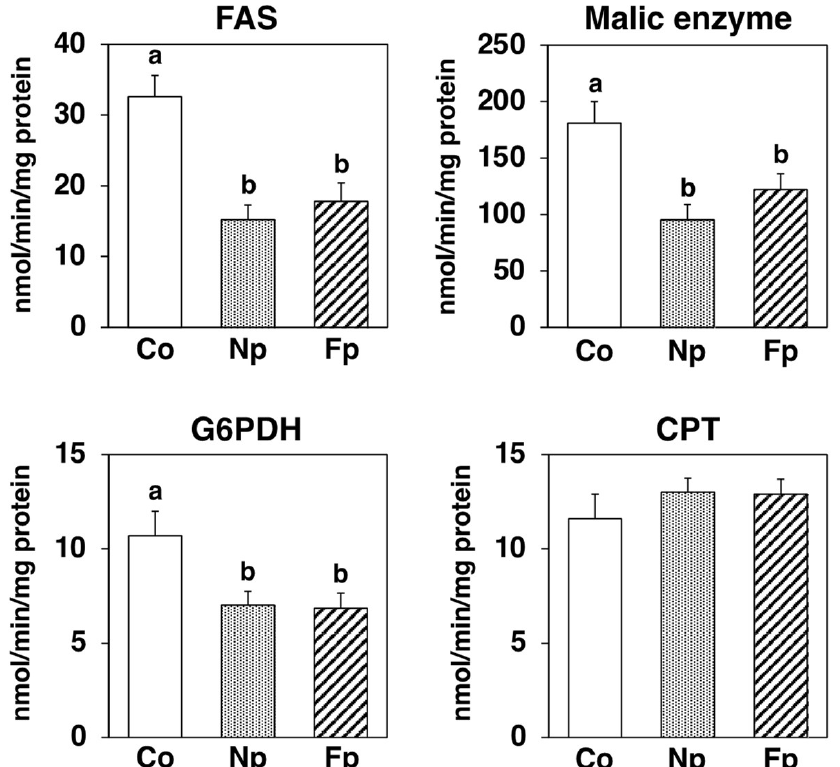
Figure 5. Activities of hepatic enzymes related to lipid metabolism in db / db mice fed a basal diet (Co group), 10% NP-supplemented diet (Np group), or 10% FNP-supplemented diet (Fp group) for 4 weeks. Values are expressed as the mean ± standard error ( n = 5–6). ab Different letters denote significant differences ( p < 0.05) among the three groups. FAS: fatty acid synthase, G6PDH: glucose-6-phosphate dehydrogenase, CPT: carnitine palmitoyltransferase.